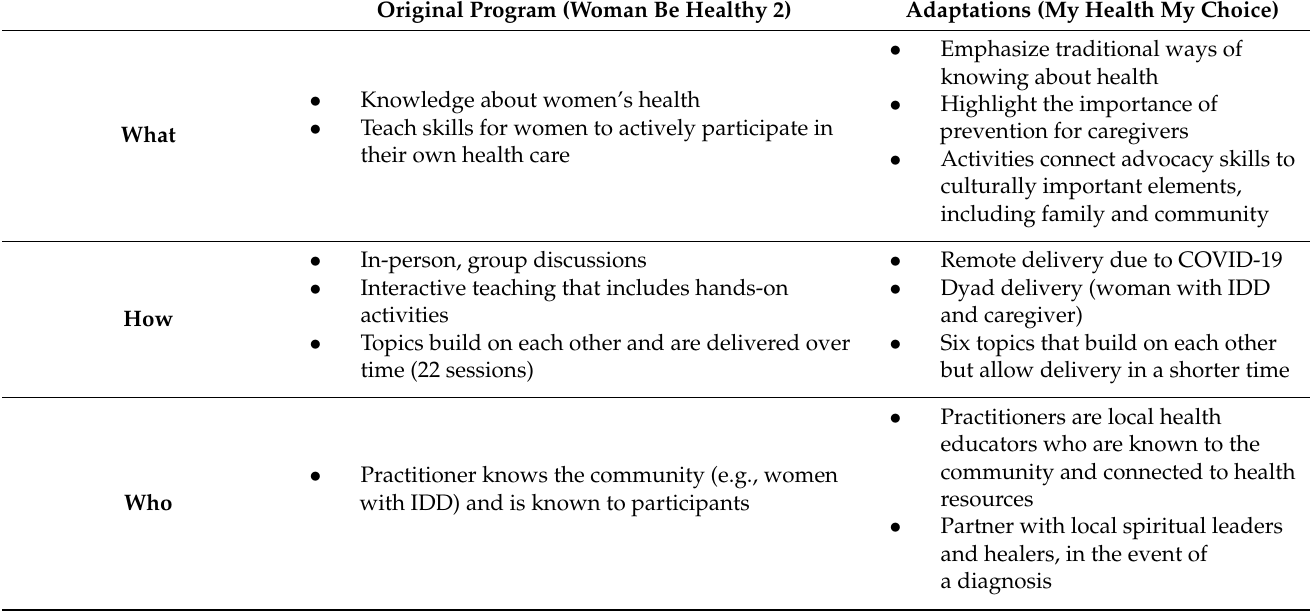
Table 2. Adapting the